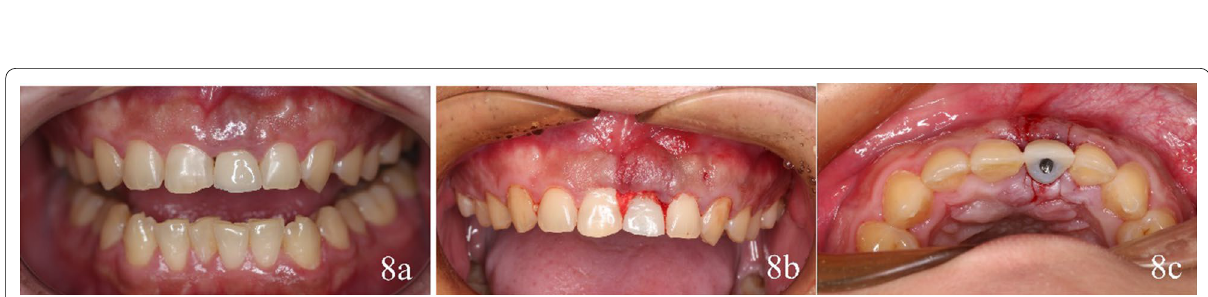
Fig. 8 a Pre-operation intraoral view. Placement of immediate interim restoration after implant surgery, b frontal view, c occlusal